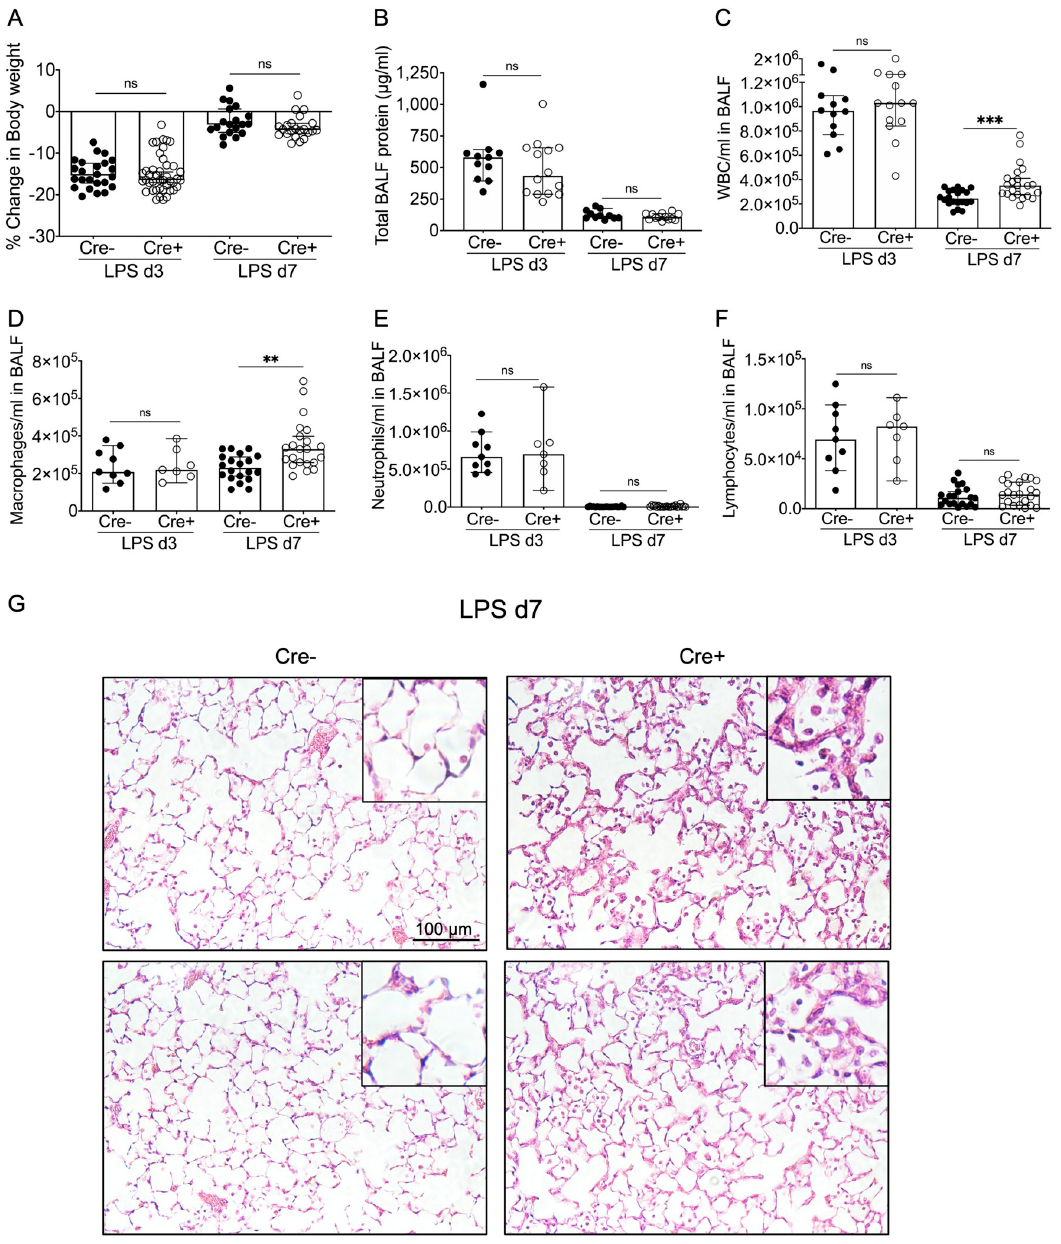
Fig 3. Characterization of lung injury and resolution in the ROSA-CreER;Npnt-Flox/Flox model. Shown are the changes in body weight (A), BALF total protein (B), and total WBC/ml in the BALF (C) at days 3 and 7 post LPS. The body weights of mice used for the day 7 time point were included in the day 3 data. Differential staining of cytospins was done to assess the macrophages (D), neutrophils (E), and lymphocytes (F) in BALF at the two time points. Shown are the medians (bars) with 95% confidence intervals. The Mann-Whitney statistical test was used to compare Cre+ to Cre- values. �� , p < 0.01; ��� , p < 0.001; ns, not significant. (G) Hematoxylin and eosin staining of sections of lung from 2 representative Cre- and 2 Cre+ mice at day 7 post LPS. Insets depict magnified areas (by 3-fold) of each image. Scale bar = 100 μ